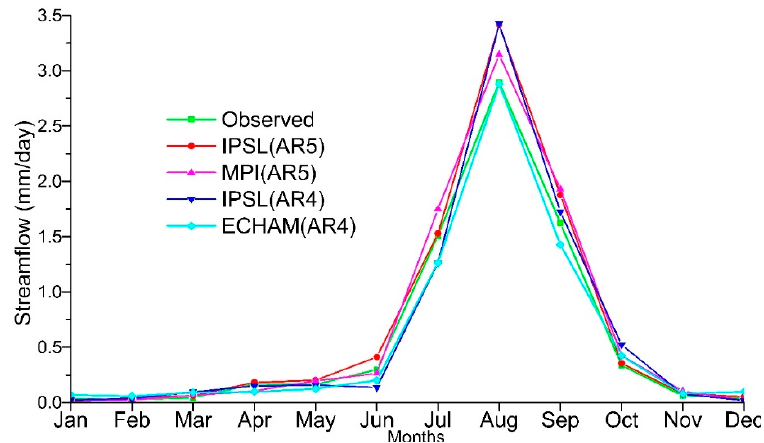
Figure 8. Observed monthly streamflow (1990–2011) and simulated streamflow with GCMs baseline (1971–2000).